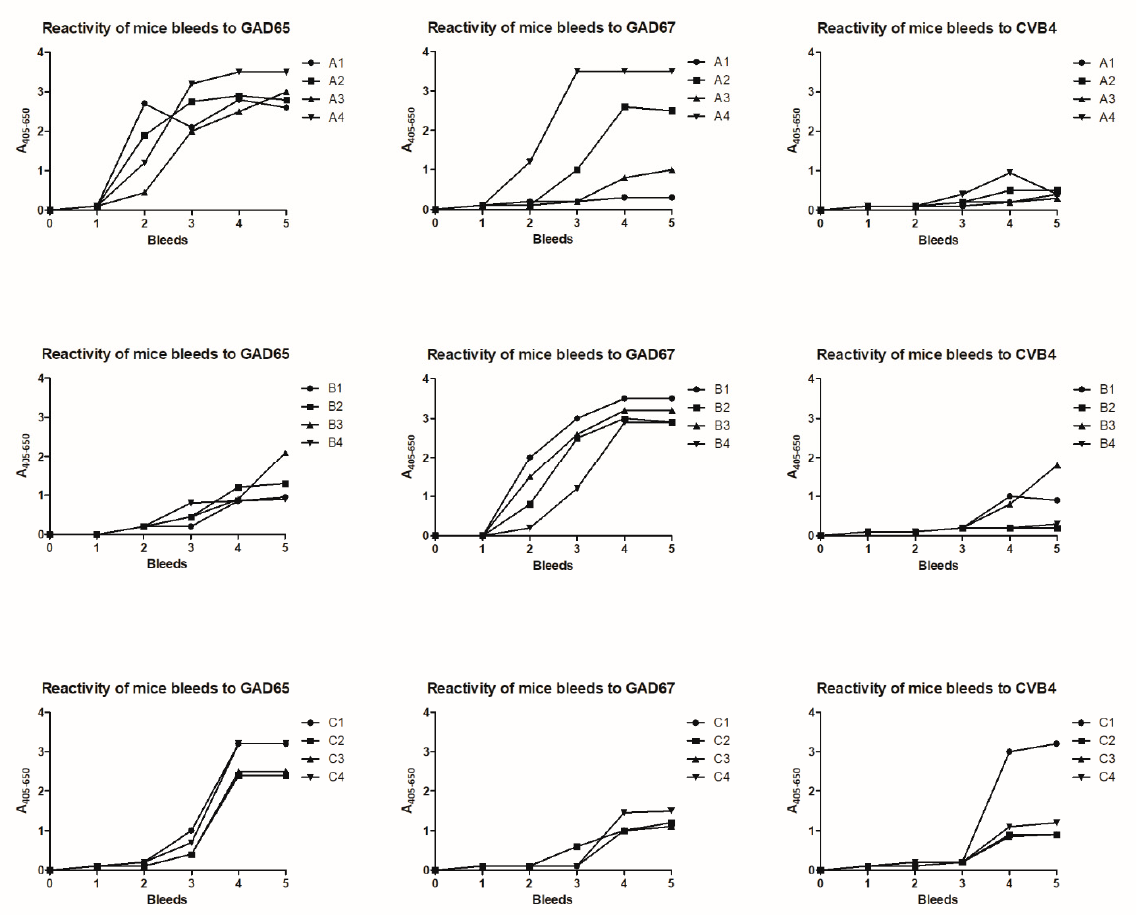
Figure 2. Reactivity of mice bleeds to glutamic acid decarboxylase (GAD)65, GAD67, and coxsackievirus (CVB) peptides in enzyme-linked immunosorbent assay. Biotinylated peptides were coated to pre-coated streptavidin microtiter plates, whereafter samples were added and antibody reactivity was determined. Bleed 0 was obtained prior to immunization, whereas the remaining were obtained after immunization. Statistically significant elevated antibody reactivity was found to the bleeds from the collected mice bleeds from bleed 5 compared to bleed